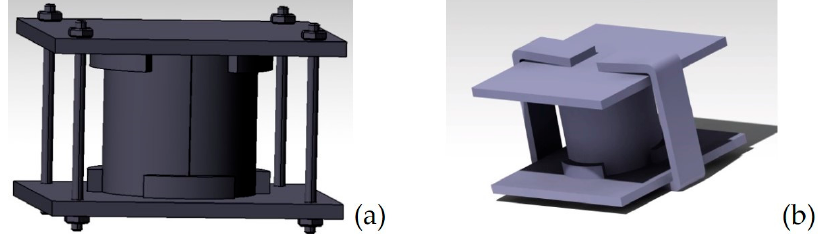
Figure 8. Molds with screw system ( a ) and with clamping system ( b ).